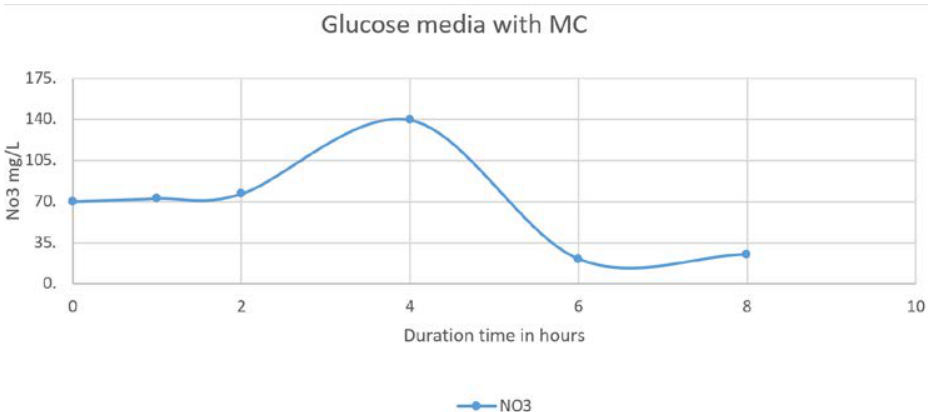
Fig. 6 . The relationship between the production of MC and bacterial growth. The maximum MC production has been achieved after 120 h when the bacteria started in the death phase.